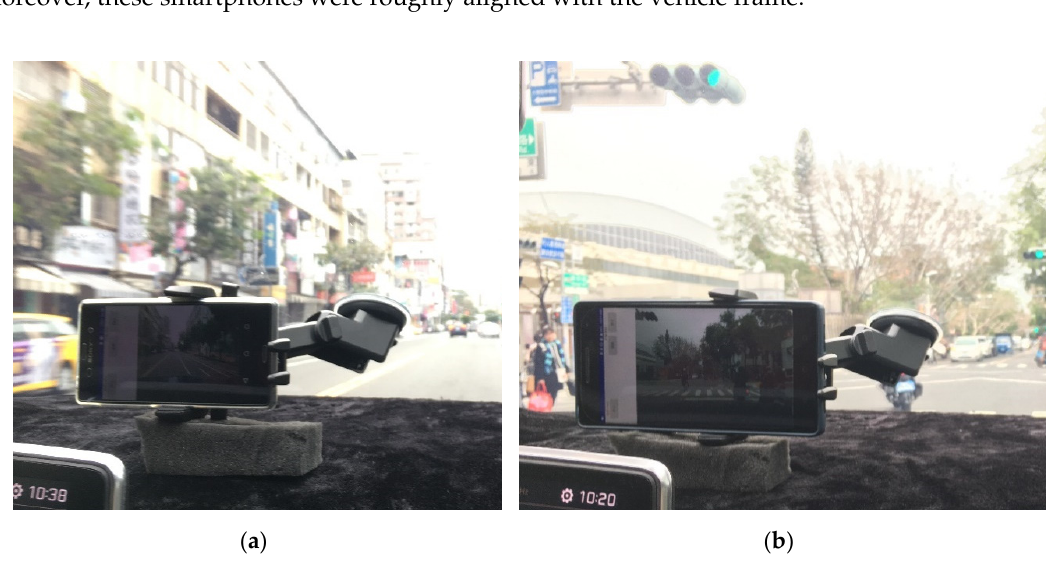
Figure 5. Smartphone setup in field tests: ( a ) Sony Xperia Z3; ( b ) Lenovo Tango.